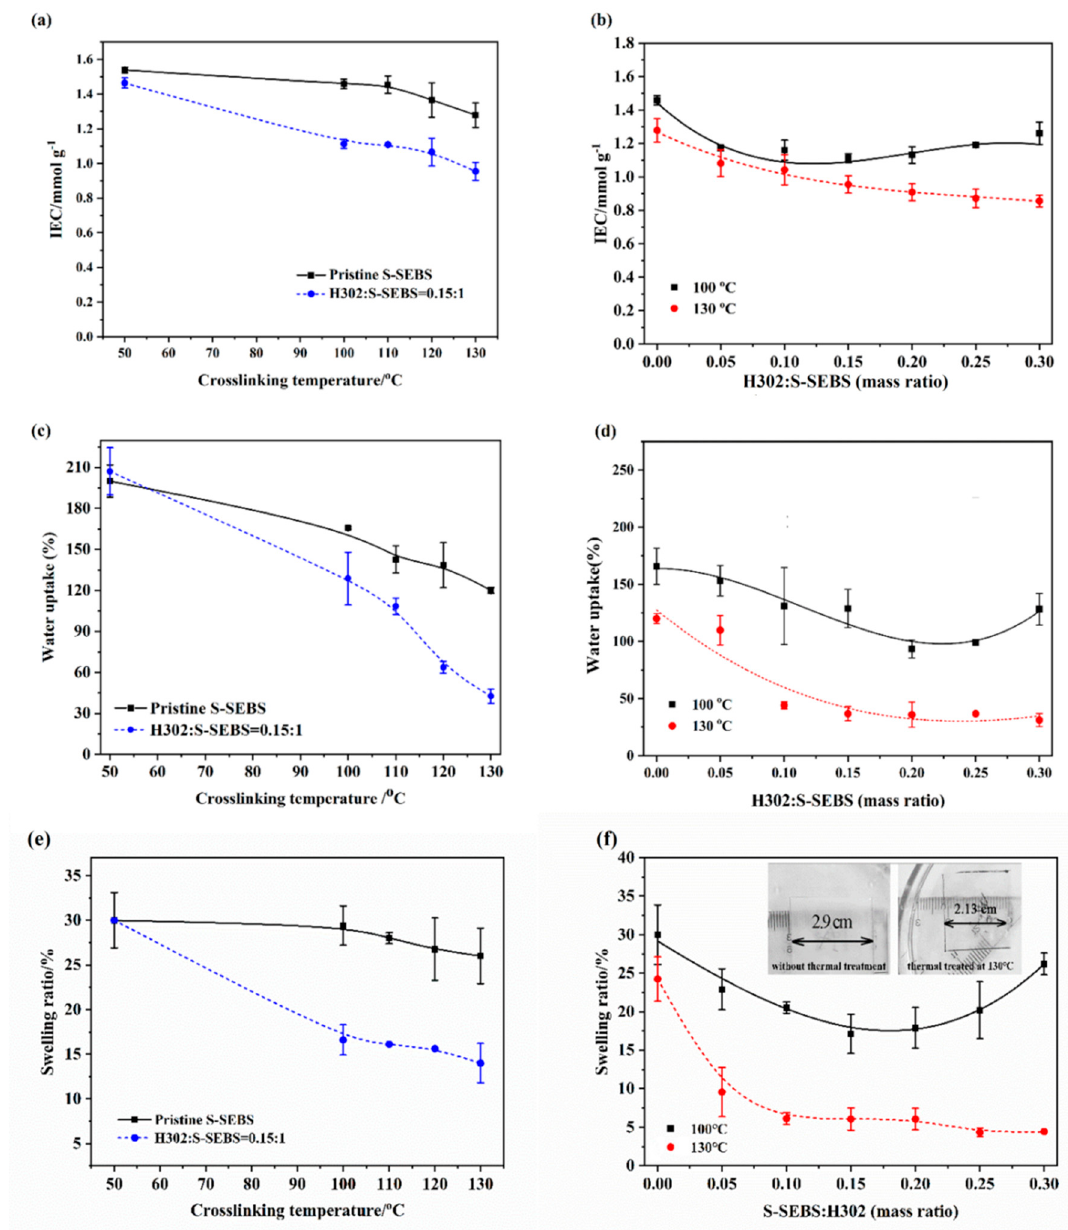
Figure 7. IEC ( a , b ), water uptake ( c , d ) and swelling ratio ( e , f ) of membranes as a function of crosslinking temperature and H302 content.